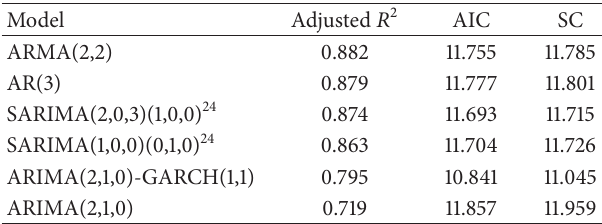
Table 1: Result of goodness of fit test.